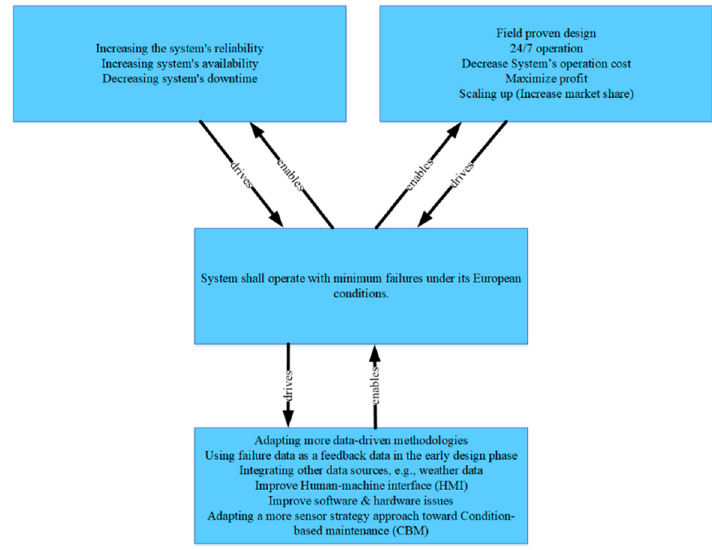
Figure 5. Value Proposition for Business and Customer.